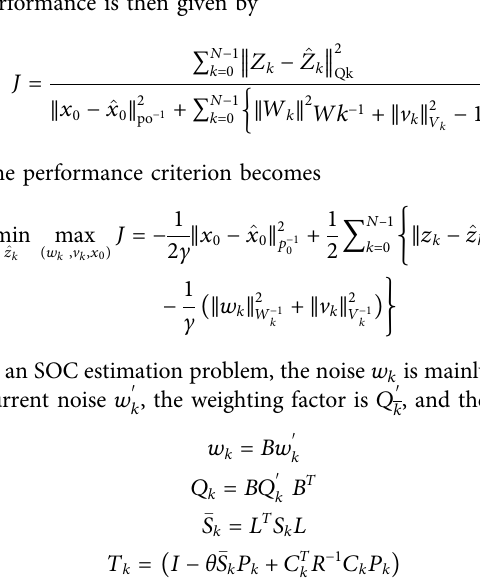
Frontiers in Energy Research |